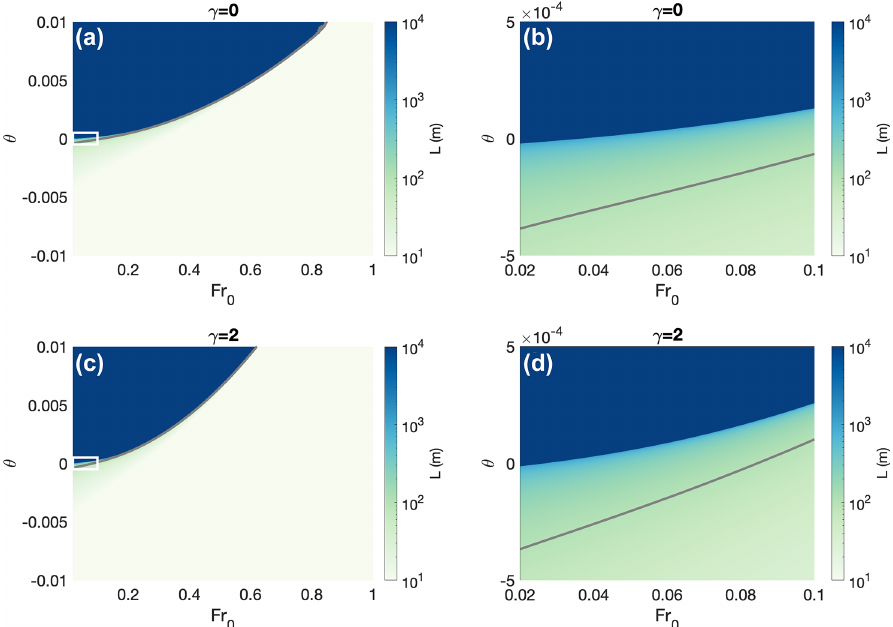
Figure 3. Seawater intrusion distance over a hard bed, calculated numerically from the full model (Eq. 5) over a range of bed slopes and Froude numbers. For illustrative purposes, the bed slope ( θ ≈ (cid:50)C 0 ) and intrusion distance ( L = (cid:96)H/C 0 ) have been shown in dimensional form for moderate parameter values ( C 0 = 0 . 005 and H = 5cm). (a–b) Unobstructed water sheet ( γ = 0). White box in panel (a) indicates region magnified in panel (b) . (c–d) Obstructed macroporous water sheet ( γ = 2). White box in panel (c) indicates region magnified in panel (d) . In all panels, C d /C i = 10. Blue regions are generally above the critical slope. Gray contour indicates 100m seawater intrusion